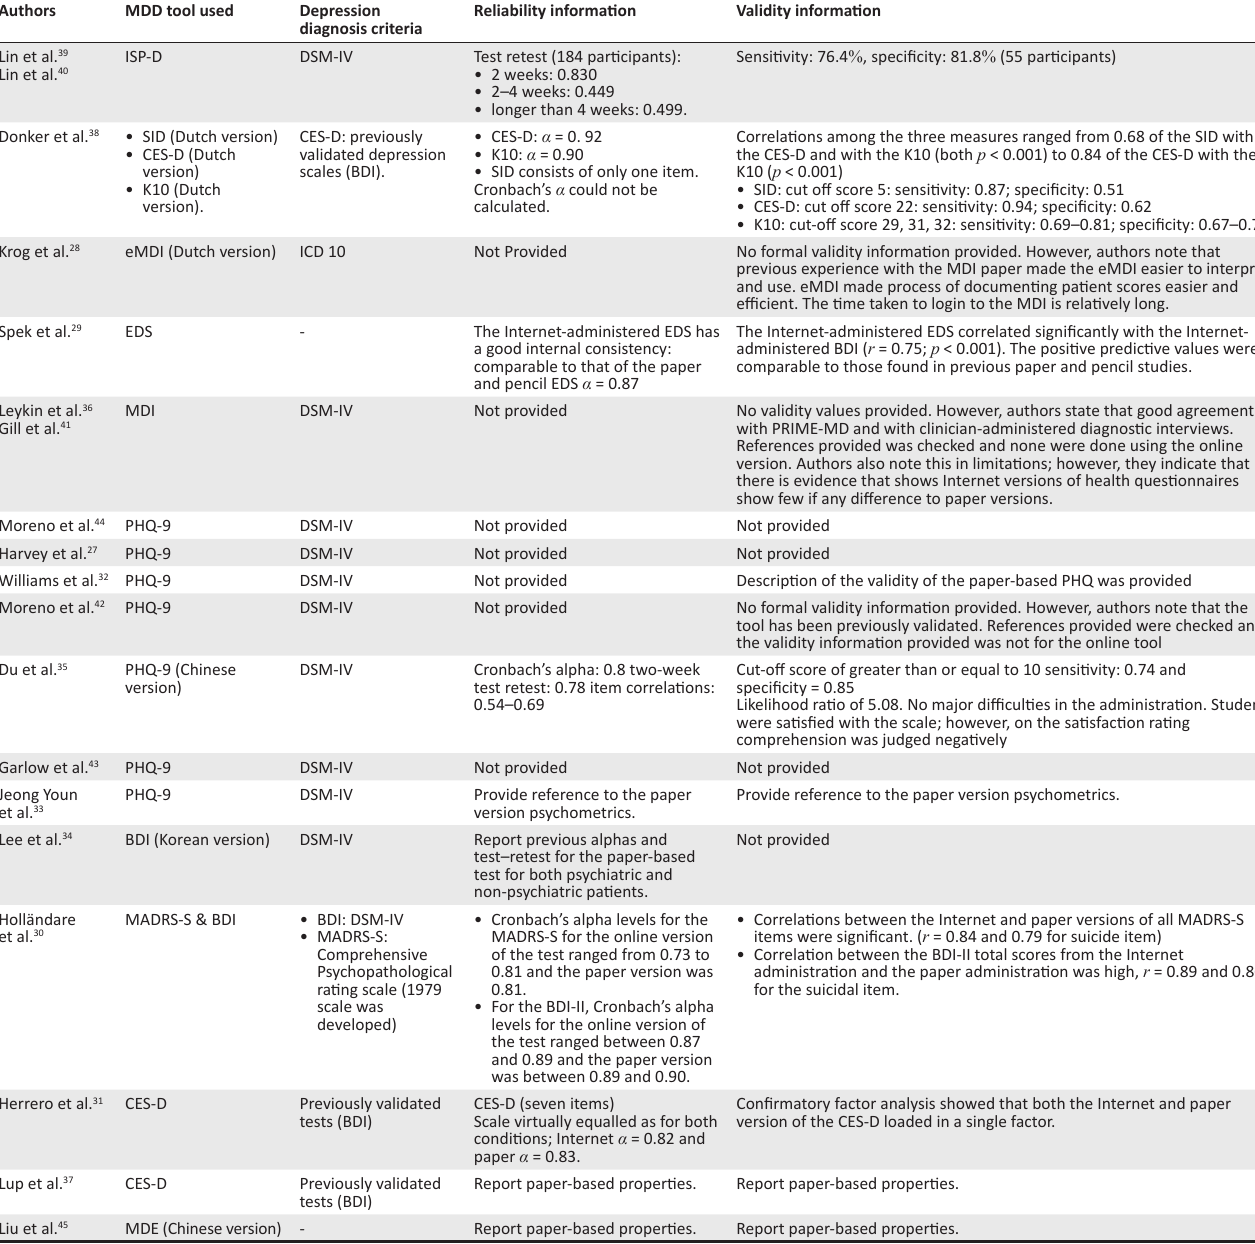
TABLE 2: Description of online depression screening